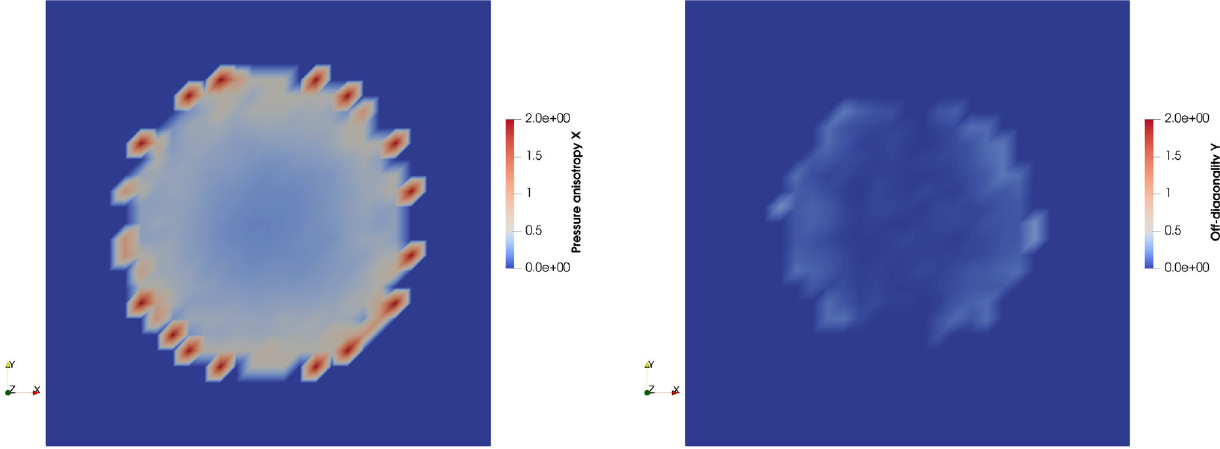
Fig. 24 Au+Au collisions at E lab = 1.23 AGeV, 0–5% centrality class, 1 event with 1080 test particles, t = 10 fm, z = 0. Average energy momentum tensor evaluated taking into account only participant hadrons. Left: Pressure anisotropy X , right: off-diagonality